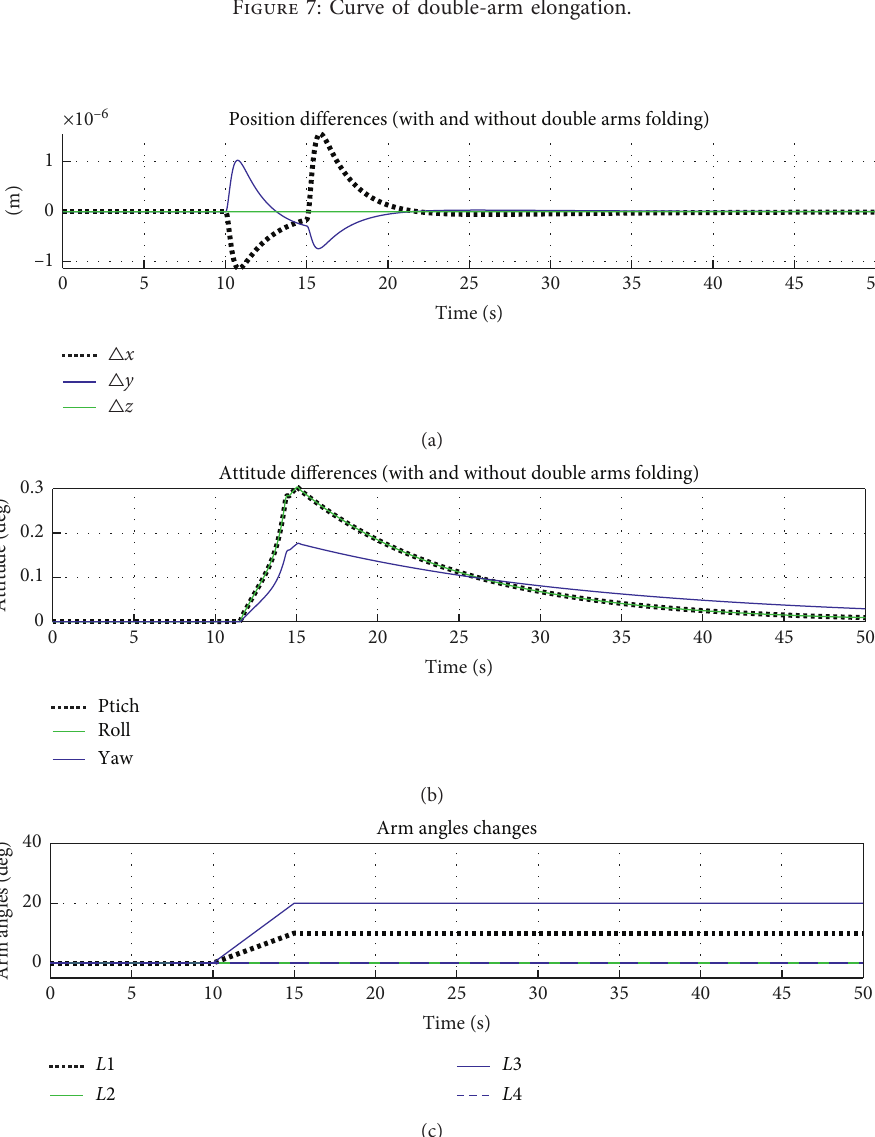
Figure 8: Curve of double-arm